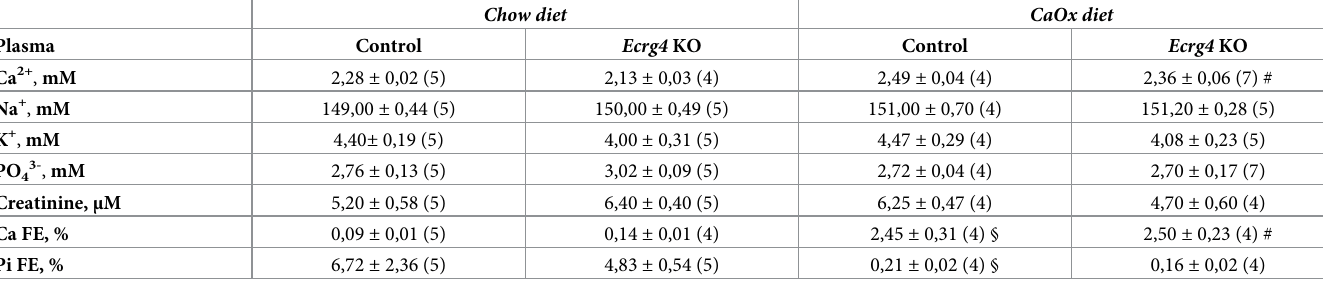
Chow diet CaOx diet